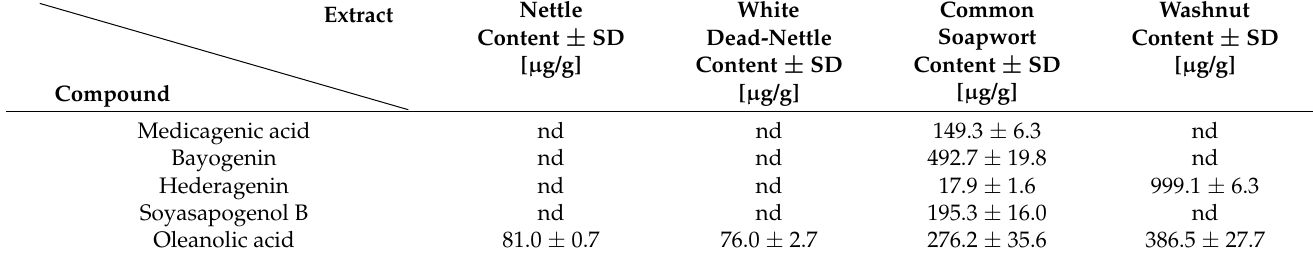
respectively. It was ascertained that sapogenins such as medicagenic acid, bayogenin and soyasapogenol were not present in any extract of washnut. Table 4. Results of quantitative analysis of extracts obtained by HPLC-ELSD technique.